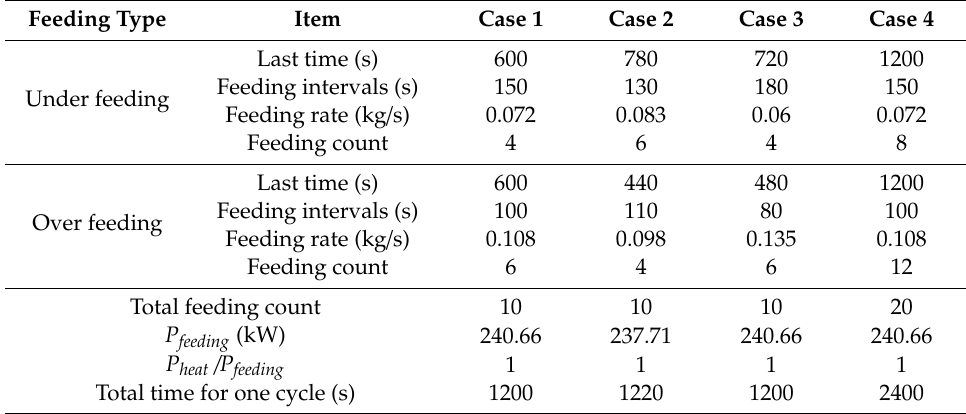
Table 2. Simulation conditions of di ff erent cases in the transient model (Cases 1–4).